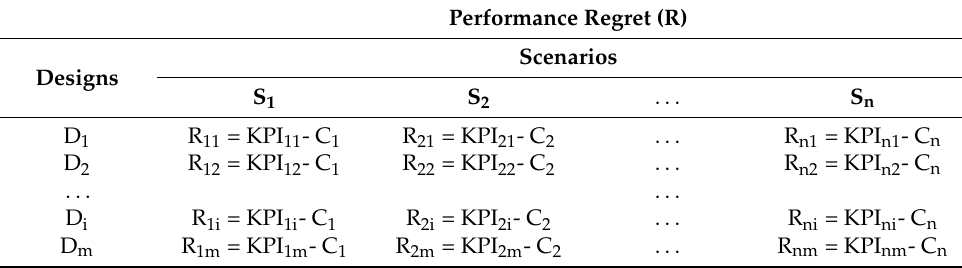
Table A2. Calculation of performance regret of designs across all scenarios [21].